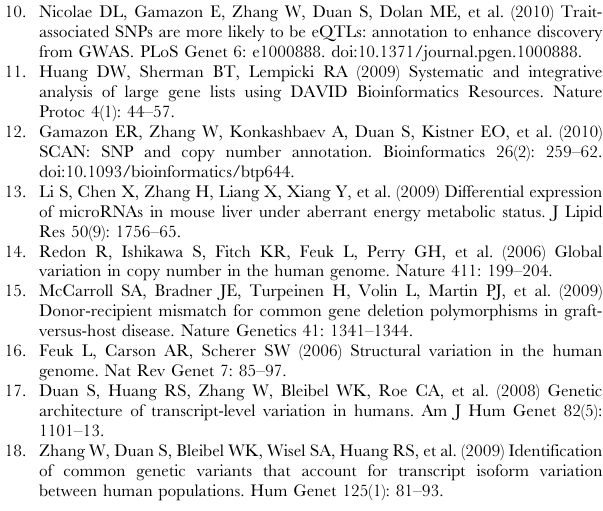
Table S2 The length of the different categories of CNVs evaluated in our